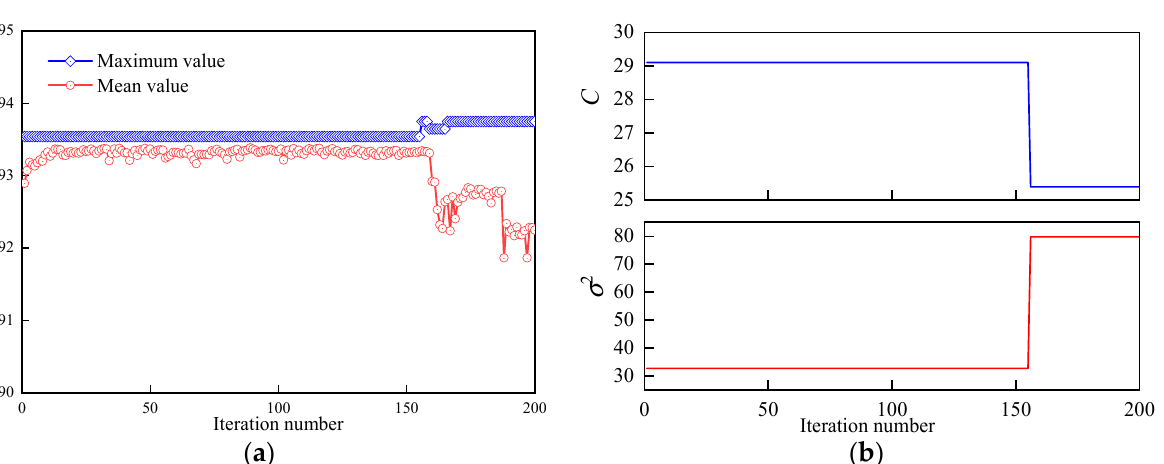
Figure 10. Comparison between linear w and nonlinear w with different parameter combinations.